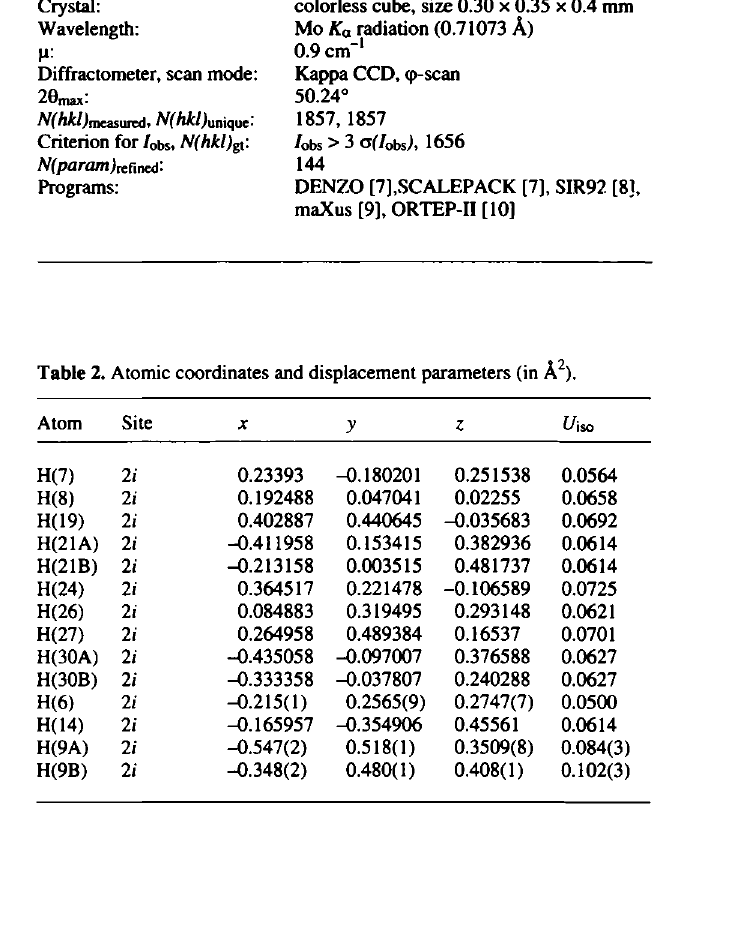
Table 1. Data collection and handling.